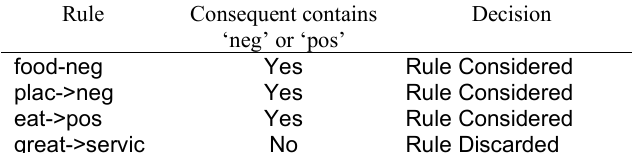
Table 3. Association rules generated on Yelp Restaurant Review Dataset